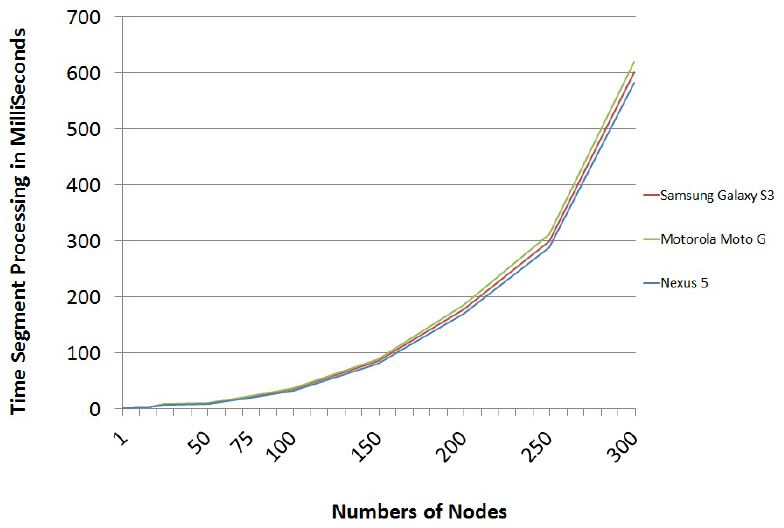
Figure 7. Segment processing time